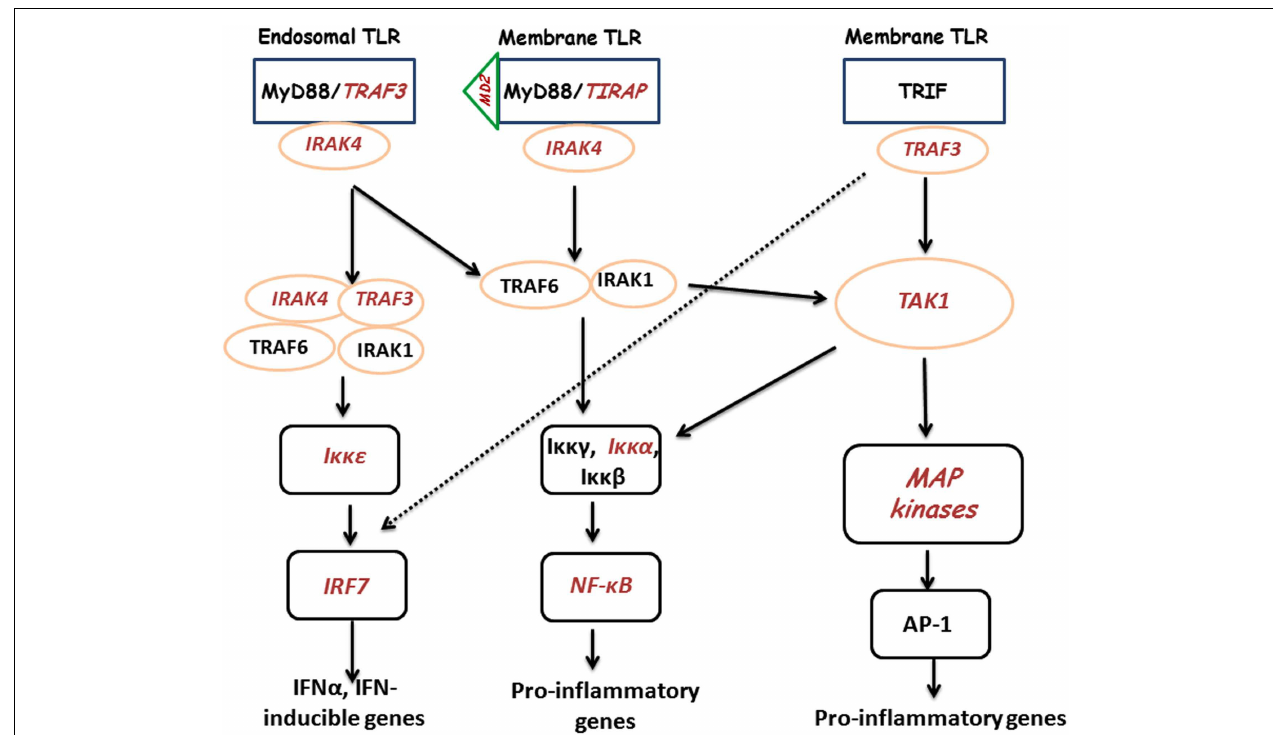
transcription factors, NF- κ B, AP-1, and IRF.Transcription factors bind to specific DNA sequences and produce effecter molecules such as cytokines, inflammatory enzymes, chemokines, and type I interferons (IFNs). Components in red italics were significantly